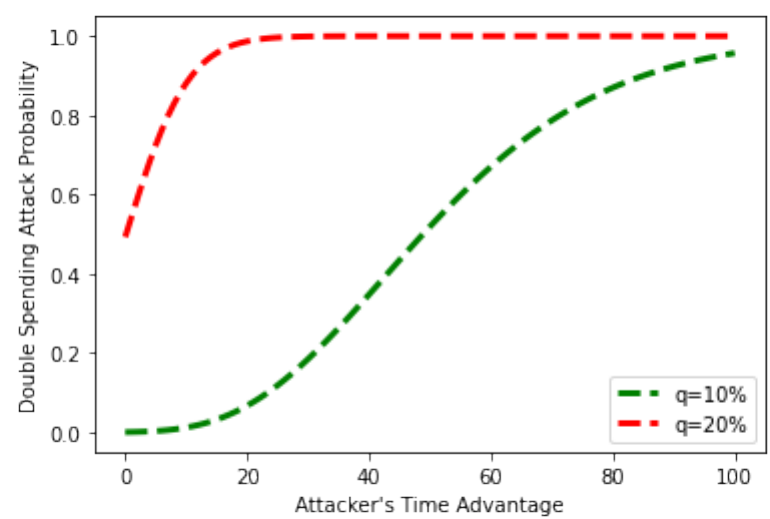
Figure 12. Double spending against time advantage of the